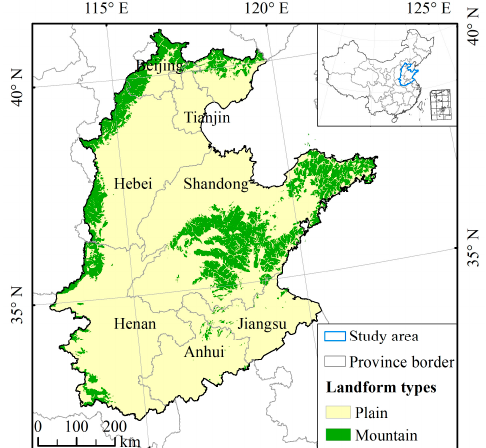
Figure 1. The location and main landform types of the North China Plain (NCP) in China.